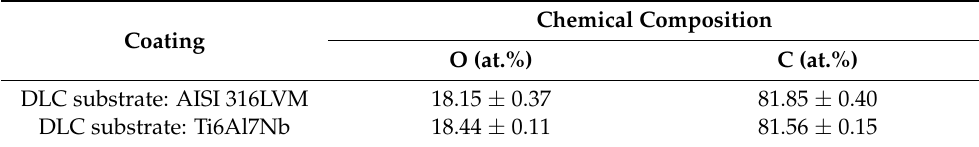
Table 1. Surface chemical composition of non-doped carbon coatings—results of XPS examination.